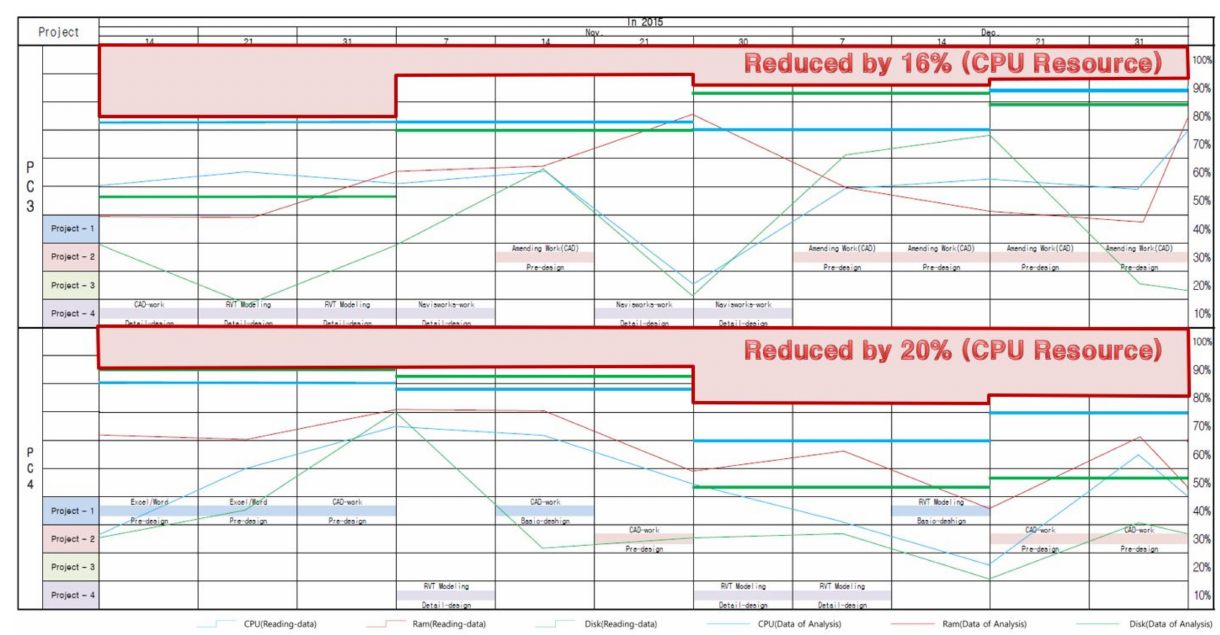
Figure 9. Comparative analysis of the VDI resource value calculated and personnel’s PC value